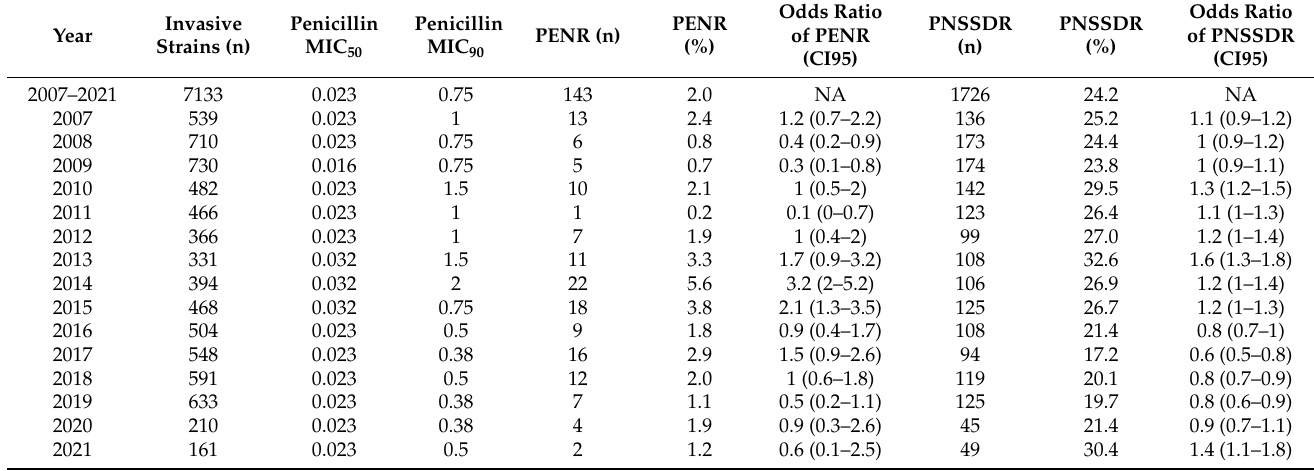
Table 1. Evolution of PENR and/or PNSSDR among S. pneumoniae invasive strains (region of Madrid, 2007–2021).